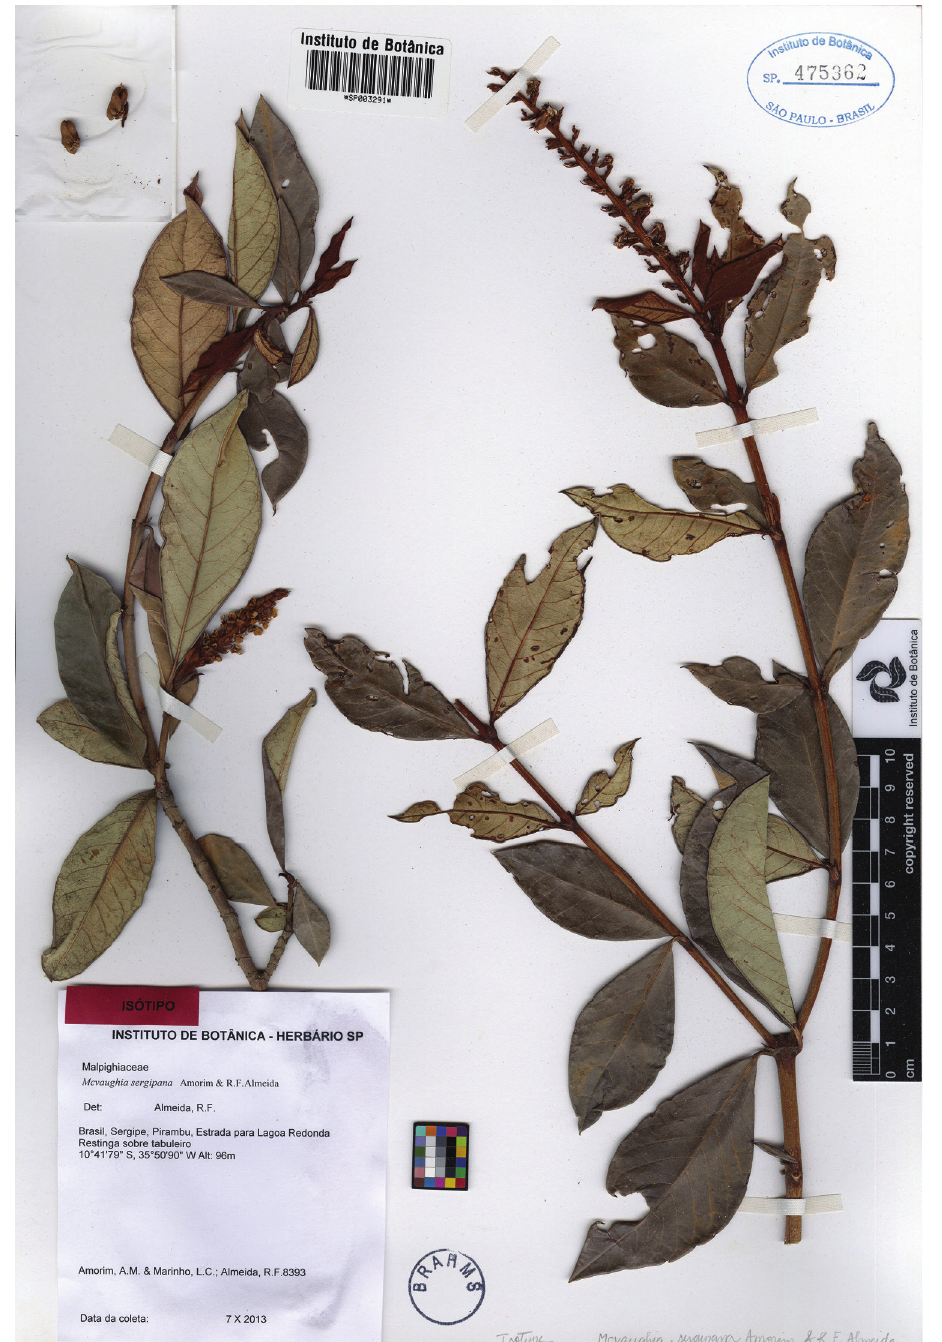
Figure 10. Photograph of the isotype of Mcvaughia sergipana